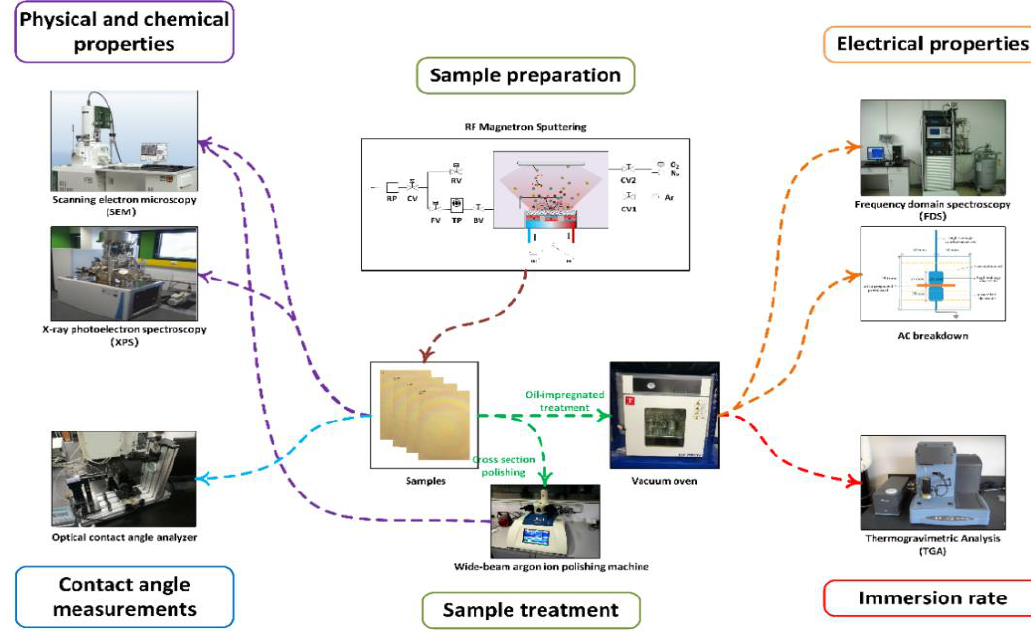
Figure 2. Flow chart of sample preparation and characterization.